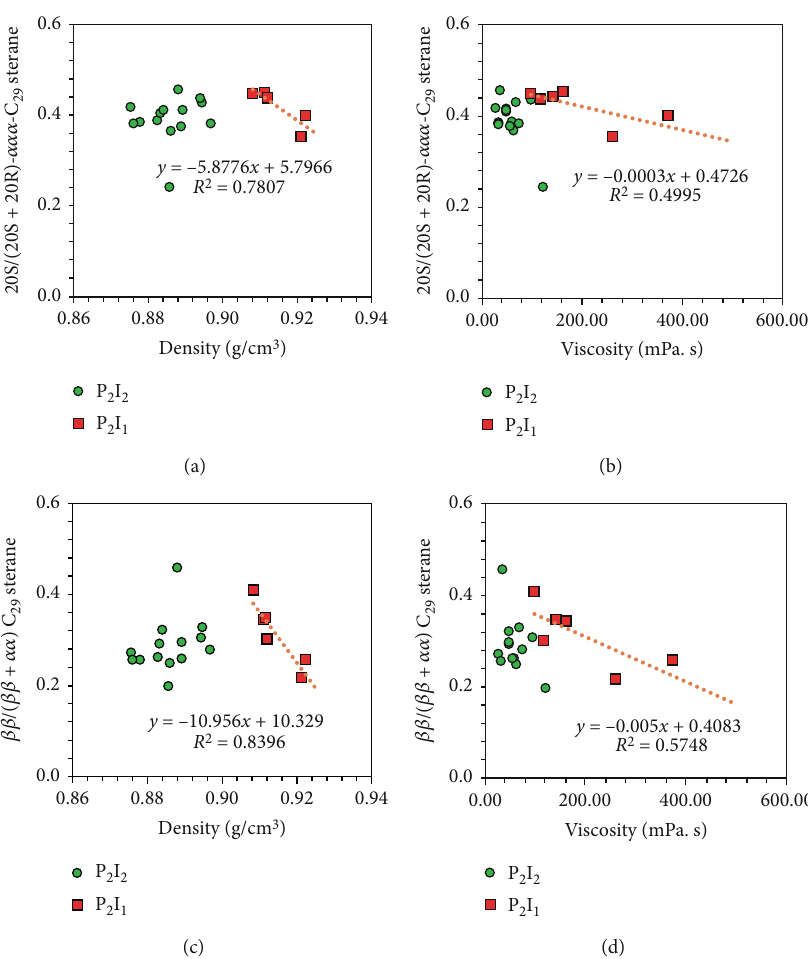
ααα 20S/( 20S + 20R ) ratio and (c) density and (d) viscosity versus 29